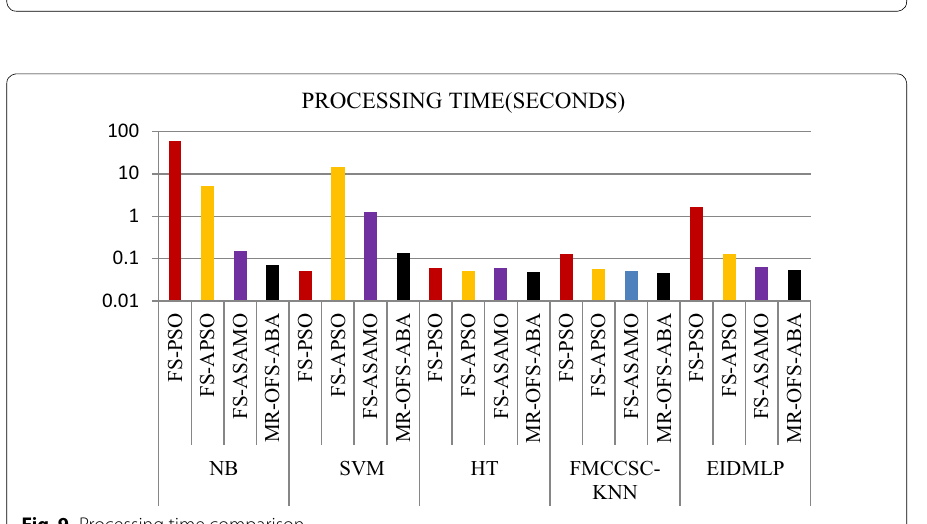
Fig. 9 Processing time